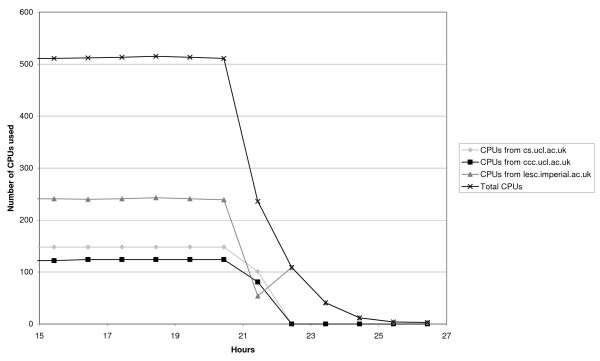
CPU usage. Number of CPUs used from each cluster at each independent Grid domain (cs.ucl.ac.uk, ccc.ucl.ac.uk and lesc.imperial.ac.uk), calculated as the number of individual jobs running at each cluster per hourly interval. For the majority of the experiment the total number of CPUs remained over 500. The tail end of the experiment is shown where the number of CPUs available begins to exceed the number of sequences left to process.